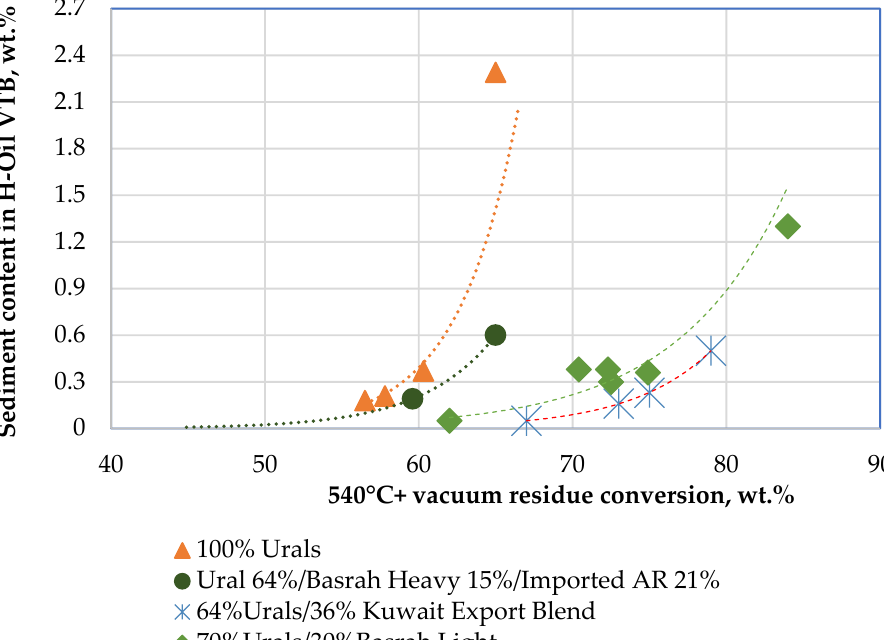
Figure 2. Dependence of hydrocracked vacuum residue sediment content on the crude oil type processed. (This data is taken from the operation of the commercial ebullated bed vacuum residue hydrocracker under study).